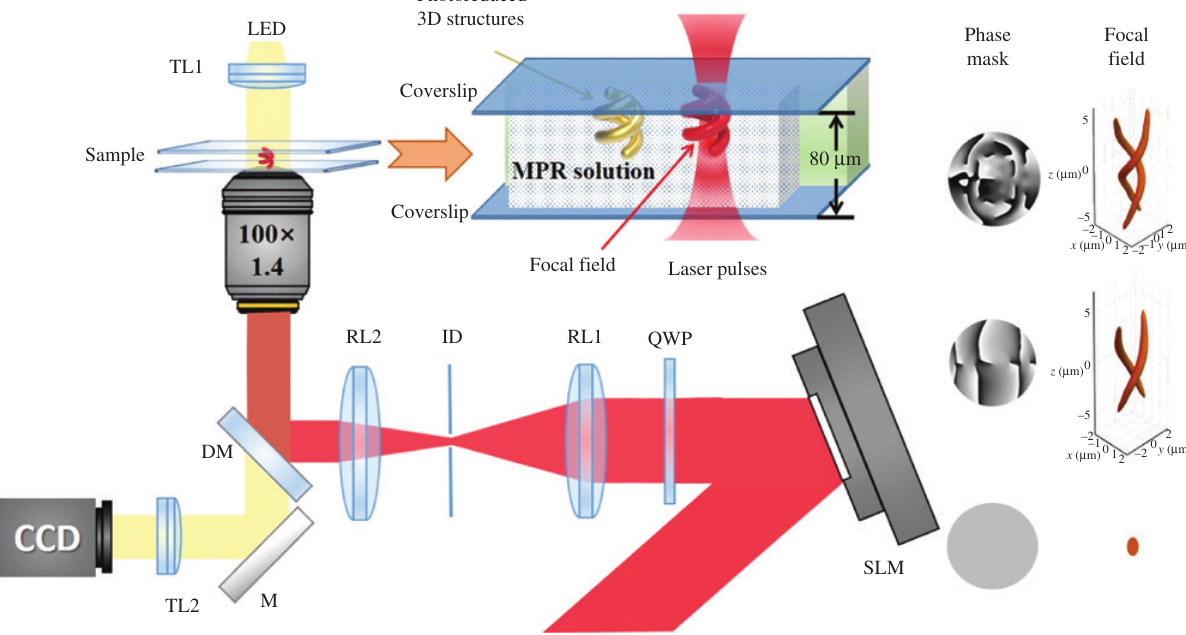
Figure 1: The schematic of the experimental setup for the single-exposure MPR. A double-helix focal field is generated by the wavefront shaping using a phase-only hologram loaded on a spatial light modulator (SLM). In the conventional direct writing approach, the phase is uniform, resulting in a simple ellipsoidal focus. QWP, quarter wave plate; RL1 and RL2, relay lenses; ID, iris diaphragm; DM, dichroic-mirror; LED, light emitting diode; TL1 and TL2, tube lens; M, mirror; CCD, charge-coupled